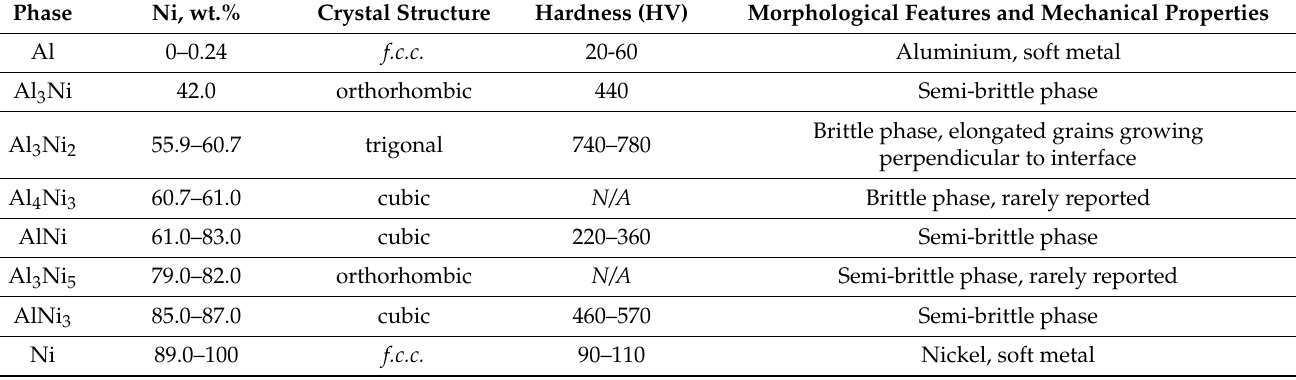
Table 4. Characteristics of different Al x Ni y phases forming at room temperature [88,112,114,121–124]. Composition of Ni (in wt.%) varies depending on temperature. Phase Ni,